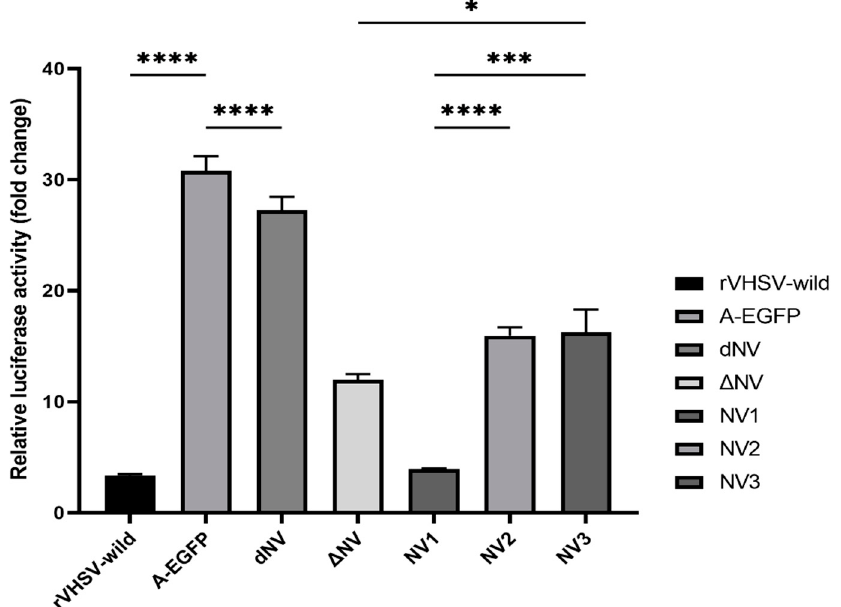
Figure 3. Analysis of Mx1 gene expression in EPC cells measured using luciferase activity. We infected EPC cells with rVHSV-wild, rVHSV-A-EGFP (A-EGFP), rVHSV-dNV (dNV), rVHSV- Δ NV ( Δ NV), rVHSV-NV1 (NV1), rVHSV-NV2 (NV2), or rVHSV-NV3 (NV3) at MOI 0.1 and assessed the luciferase activity at 24-h post-infection (n = 6, means ± SD, * p < 0.05, *** p < 0.001, **** p < 0.0001).